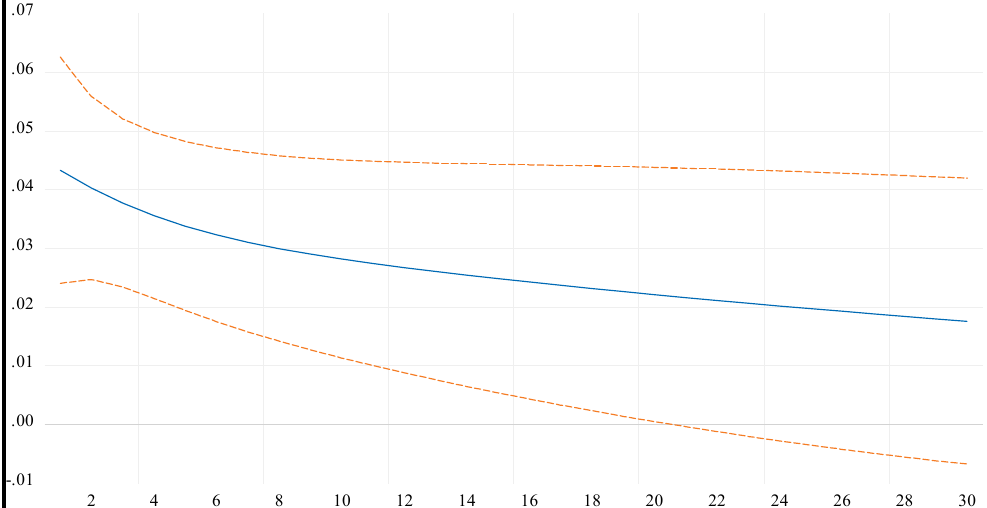
Figure 4. Response of LGDP to RES using structural VAR factor.